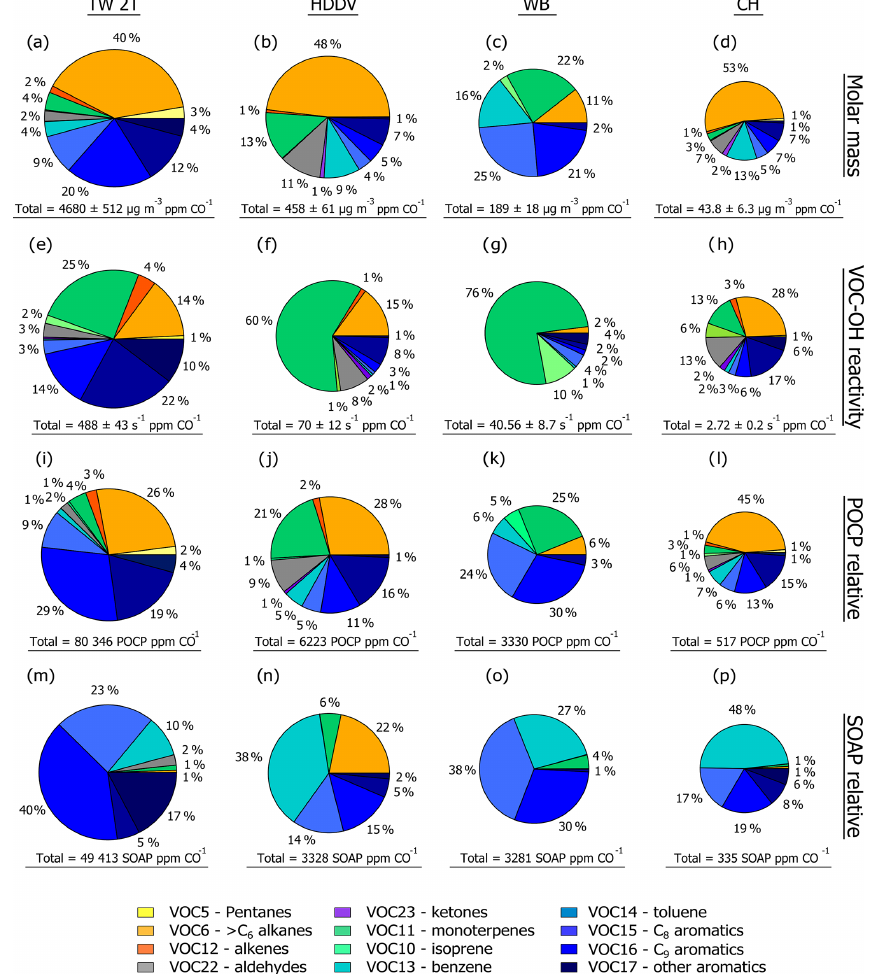
Figure 7. Contributions of VOC emission ratios to (a) – (d) the measured molar mass, (e) – (h) OH reactivity, (i) – (l) relative ozone formation potential POCP, and (m) – (p) relative SOA formation potential, aggregated in VOC families. Absolute totals for each source are shown below each pie chart in the respective